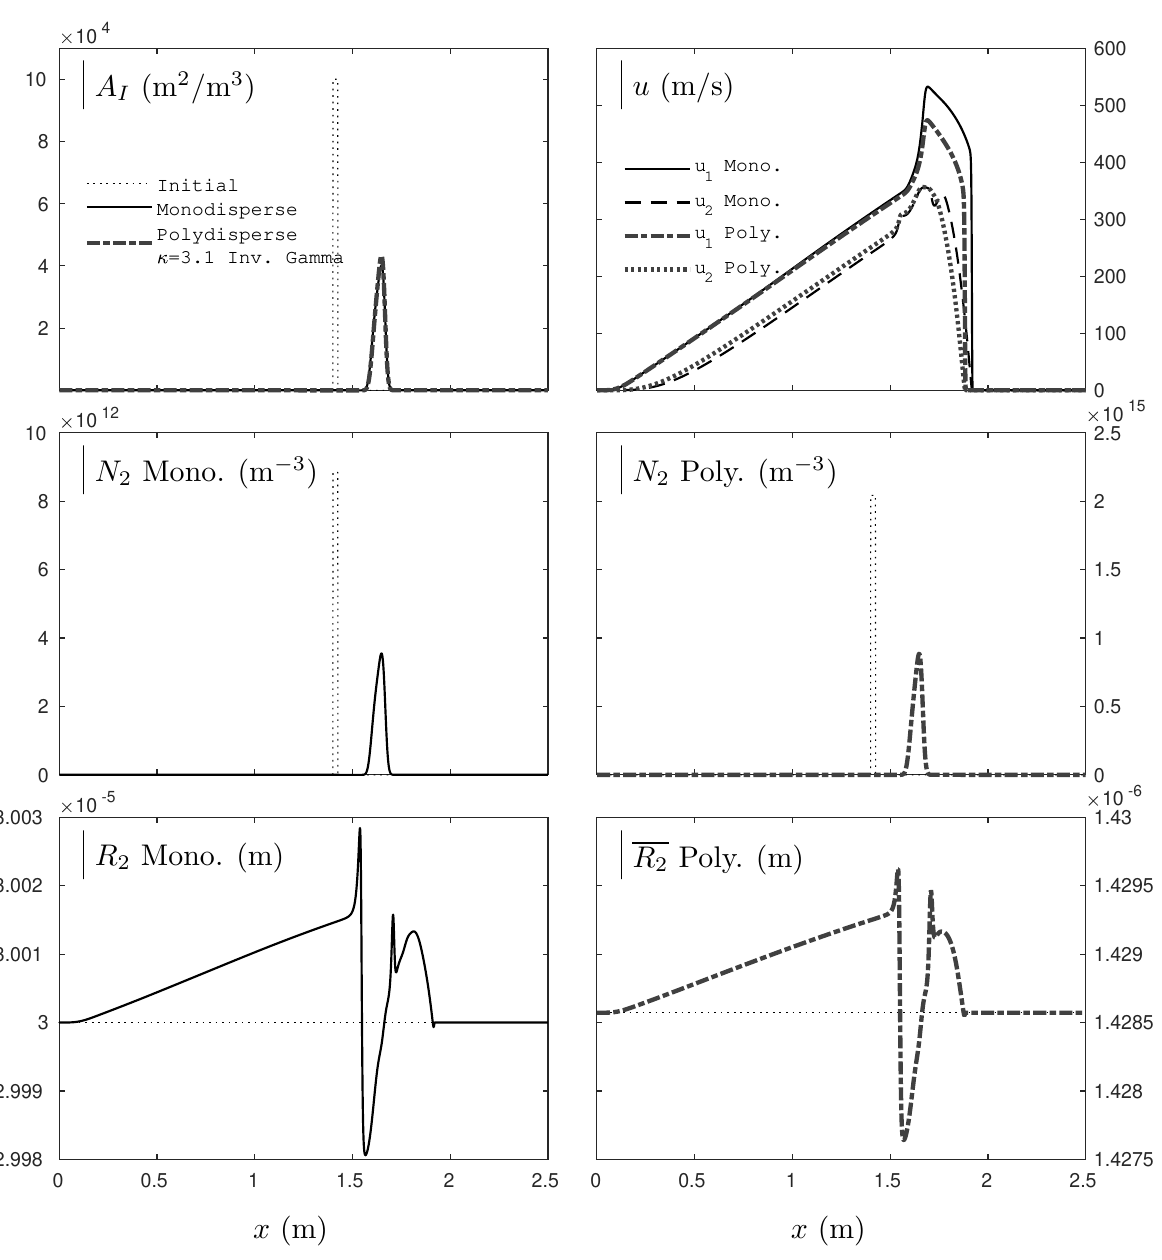
Figure 13: Simplified two-phase explosion test depicted in Fig. 5. Comparison of the monosdisperse and polydisperse results. The initial specific interfacial area is the same for both computations A t =0 = A t =0 and is computed via an initial monosdisperse radius of R t =0 = 30 µ m. For the polydisperse computation, the Inverse Gamma distribution is used with κ = 3 . 1. I ,mono. 2 2 I ,poly. All results are given at time t = 1 . 2 ms and are presented in terms of A I , u , N 2 and R 2 for both computations. As the κ parameter tends towards its lower limit, differences between the two solutions are visible.